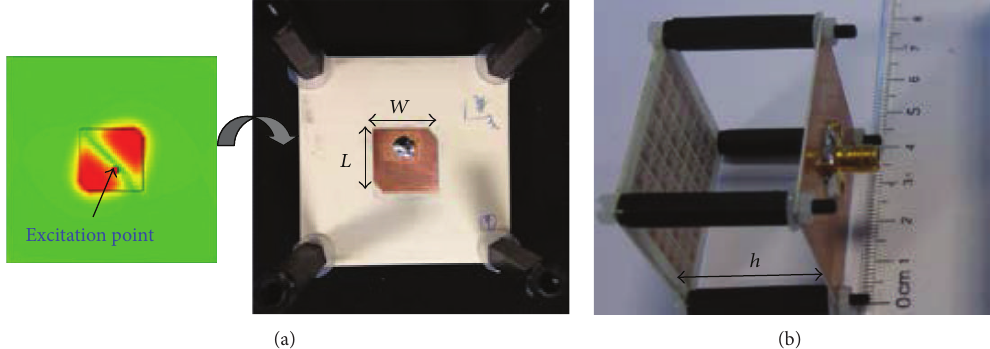
Figure 13: Prototype of FL-LHM antenna: (a) circularly polarized patch reference antenna; (b) prototype of FL-LHM antenna.